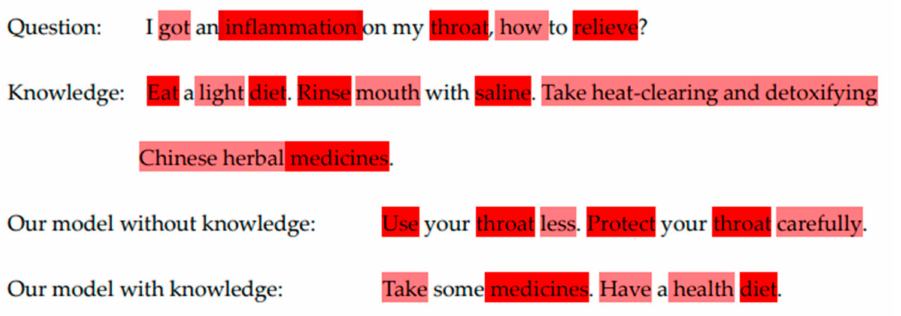
Figure 10. The attentive visualization of background knowledge effectiveness in answer selection. The shade of color marks the importance of the word. The darker the color, the more